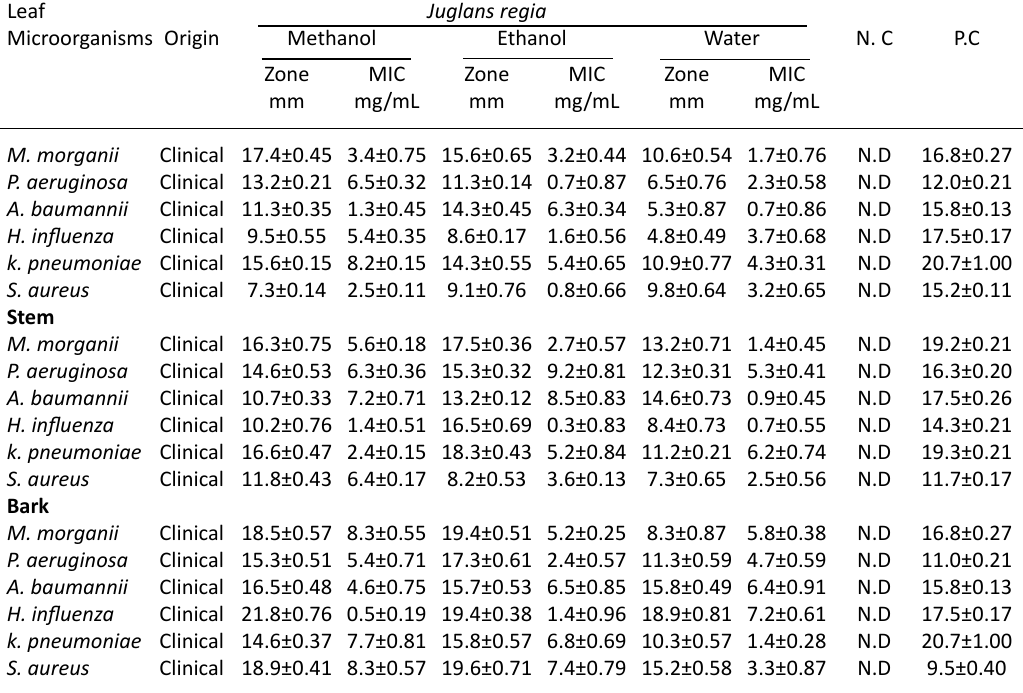
Table 1. Antibacterial activity of Juglans regia extracts against bacterial pathogens Leaf